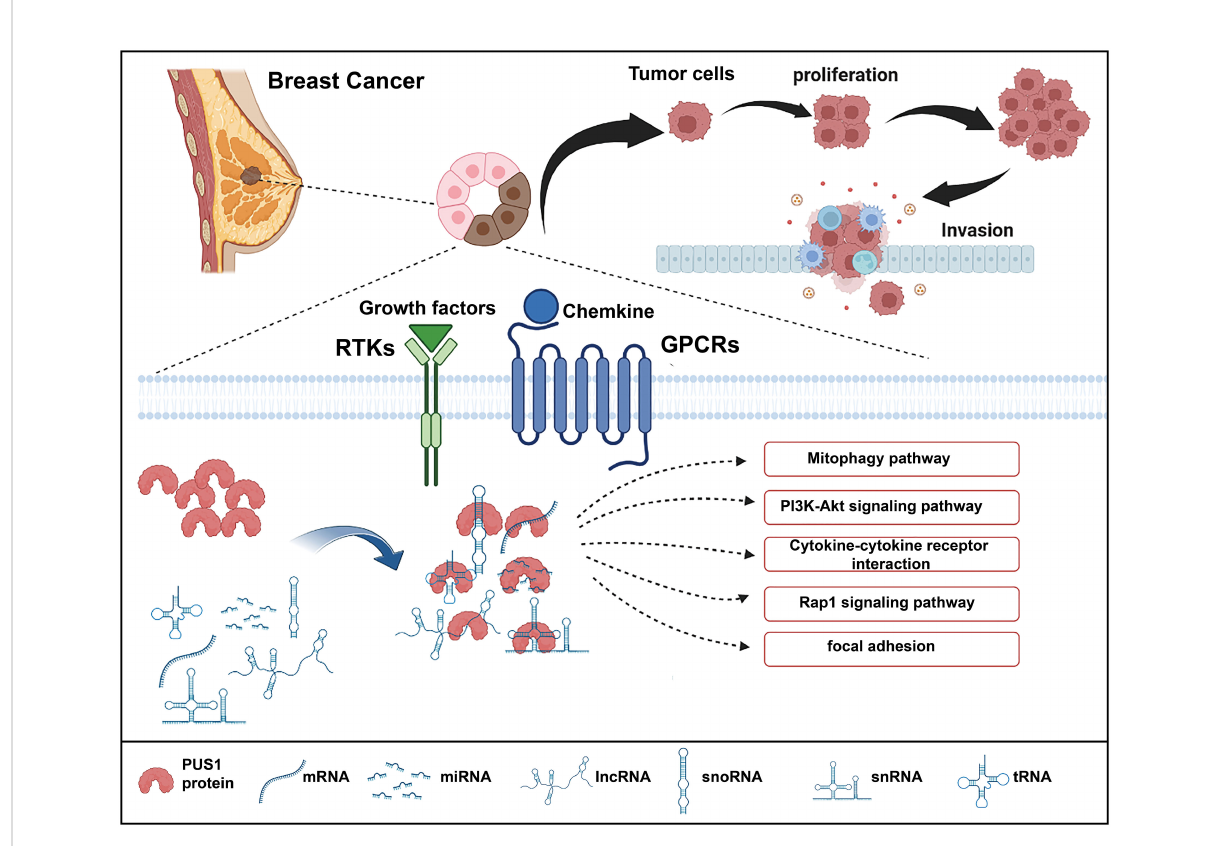
FIGURE 5 Schematic illustration of the functions of PUS1 and its potential regulation mechanisms in breast cancer. Upregulation of PUS1 promotes malignant biological behavior of tumor cells by regulating a series of cancer related biological processes and